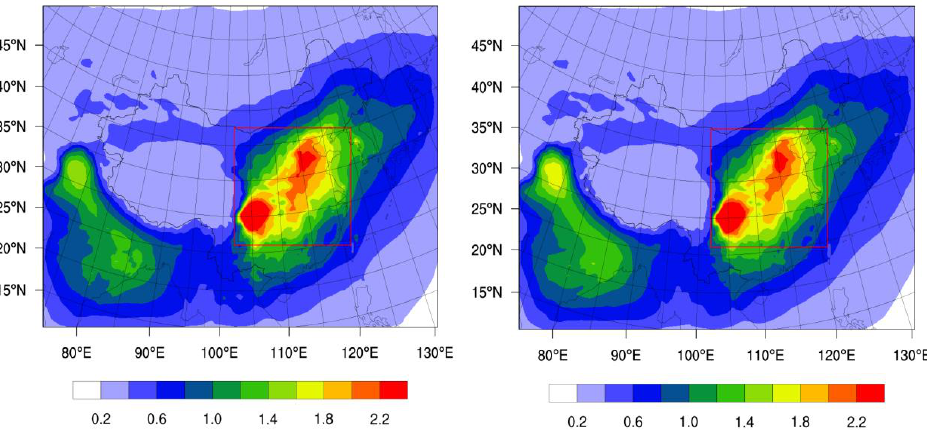
Figure 7. Spatial distributions of annual average sulfate aerosol concentrations (μg kg −1 ) over East Asia during the daytime ( left ) and nighttime ( right ) in 2010.